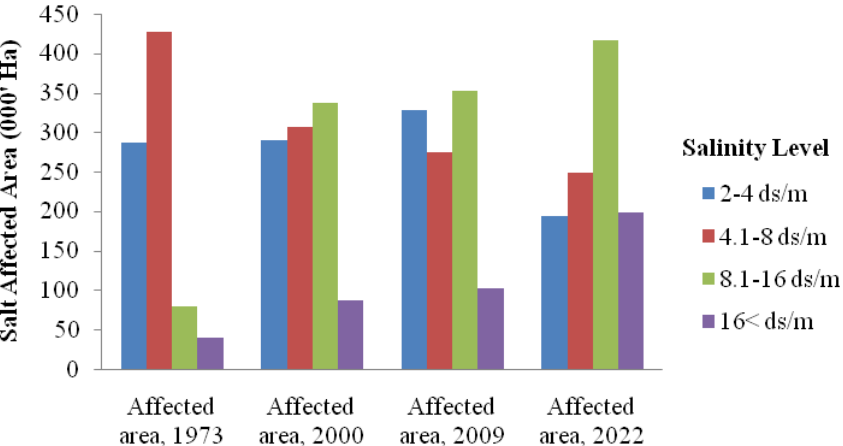
Figure 4. Saline-affected areas of the coastal region in 1973, 2000, 2009, and 2022.